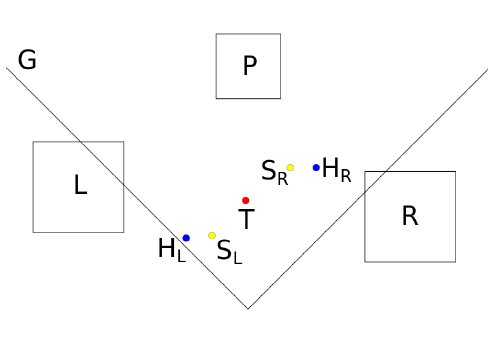
Figure 2. Schematic diagram of the experimental setup, seen from above. G is the glass plate, L the stool of the left participant, R the stool of the right participant, P the wooden rack, which can be used as platform, H L and H R the resting places for the right hand of the left or right participant, respectively, S L and S R the start and destination positions of the plastic can, which can change their roles together with the role of the participants, and T the place of the hand-over.